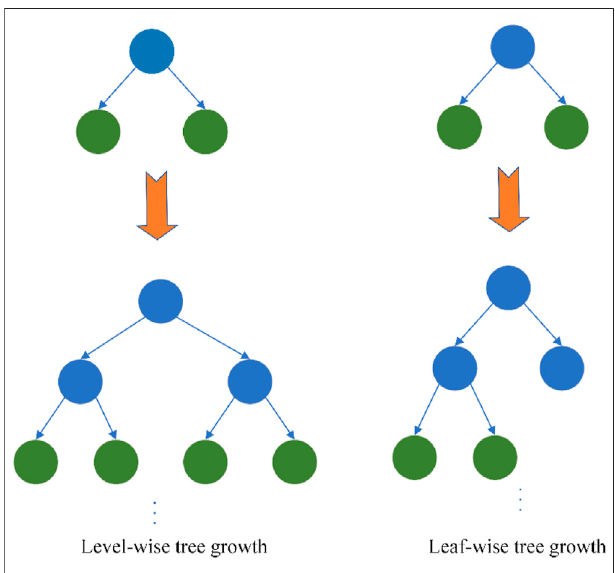
FIGURE 2 | Comparison of level-wise tree growth and leaf-wise tree